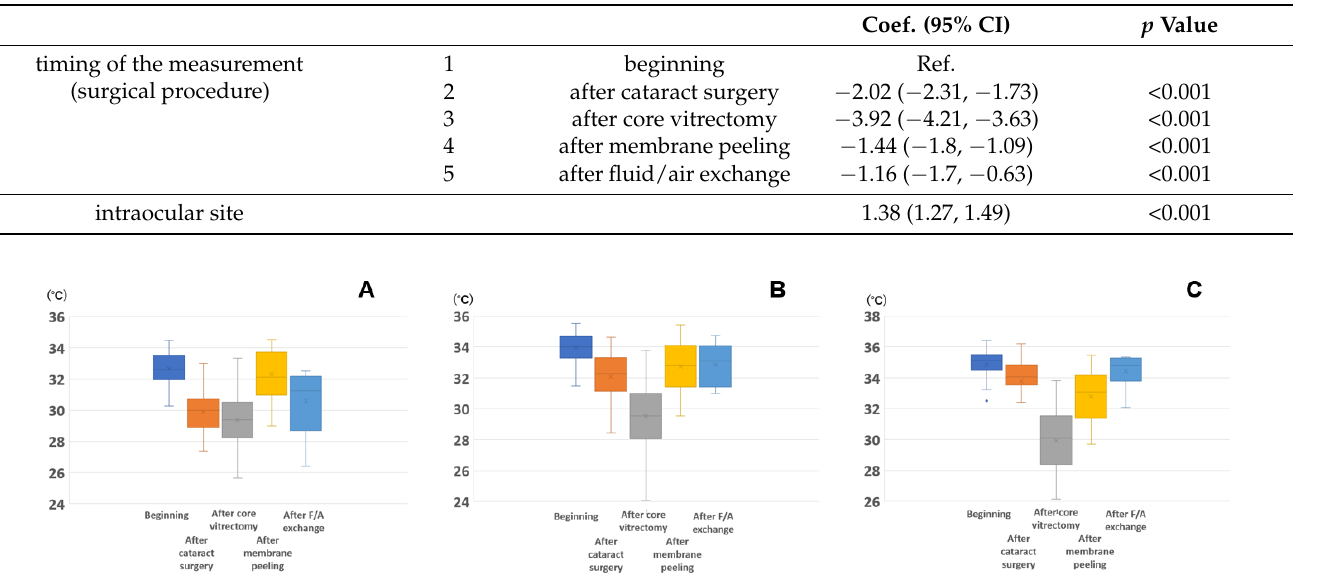
Table 2. Association between the intraocular temperature and variables using multivariable analysis.